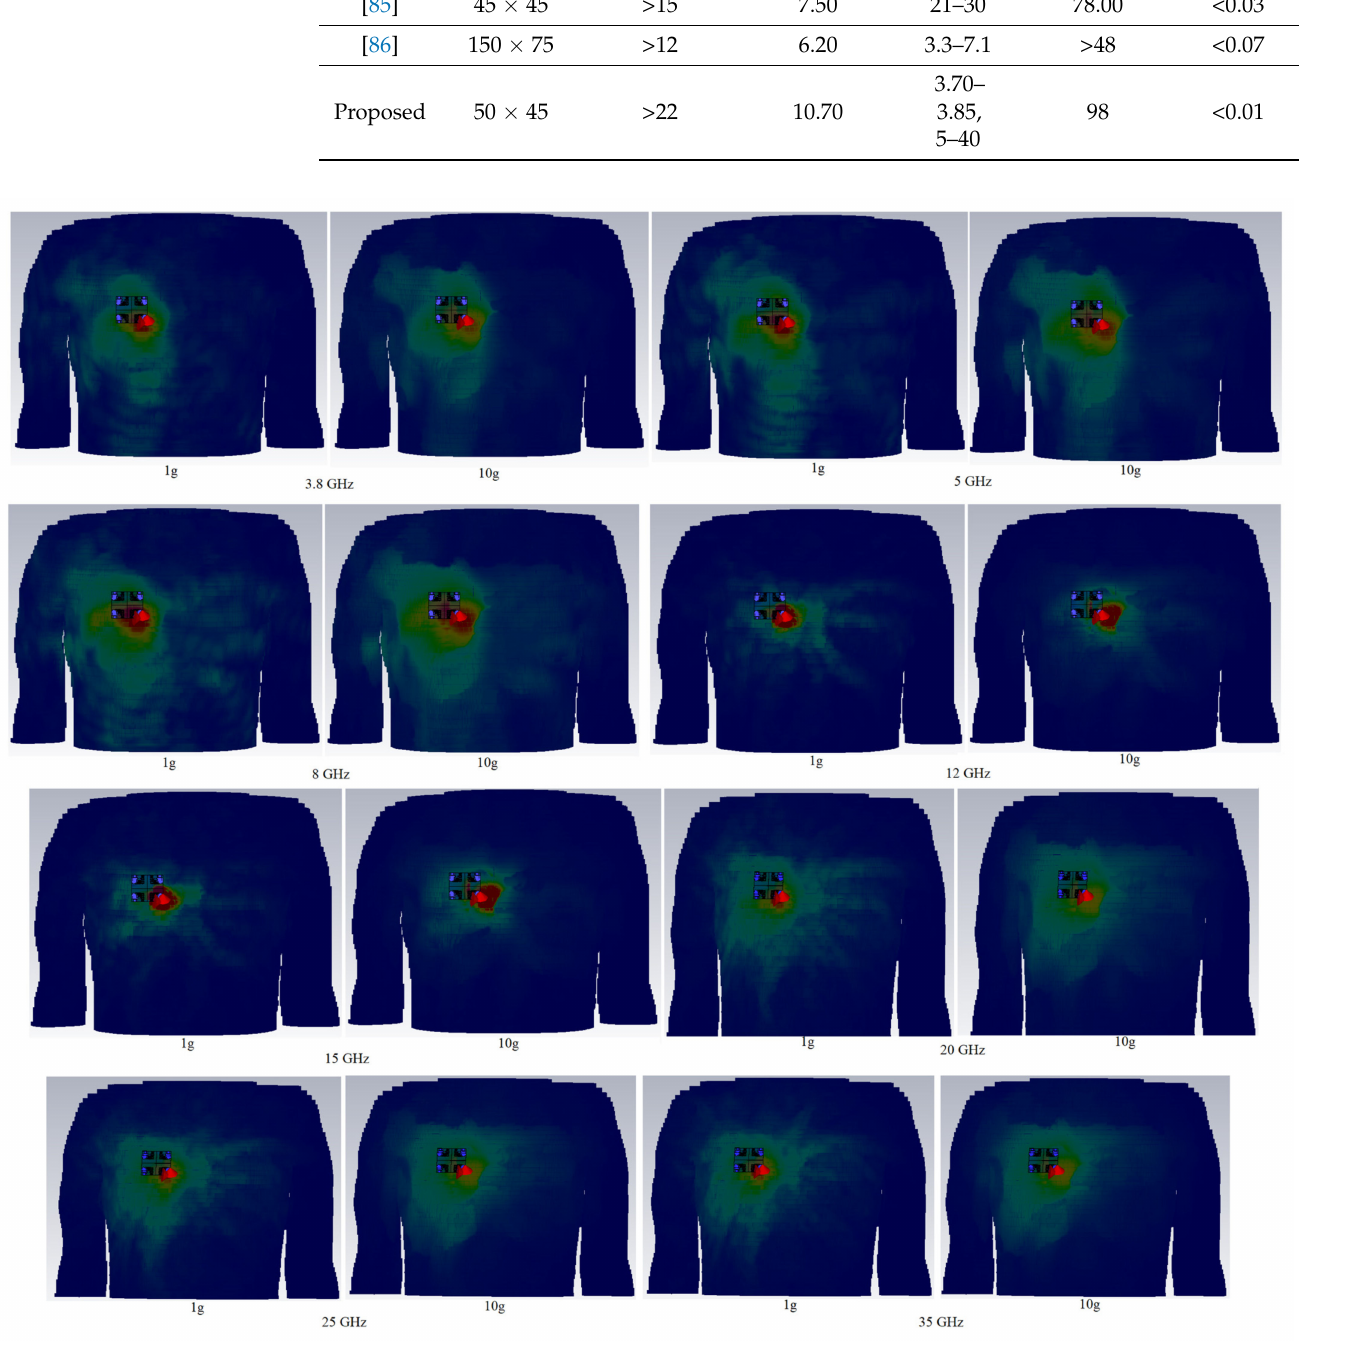
Figure 28. Simulated SAR distribution for the MIMO antenna on chest at different